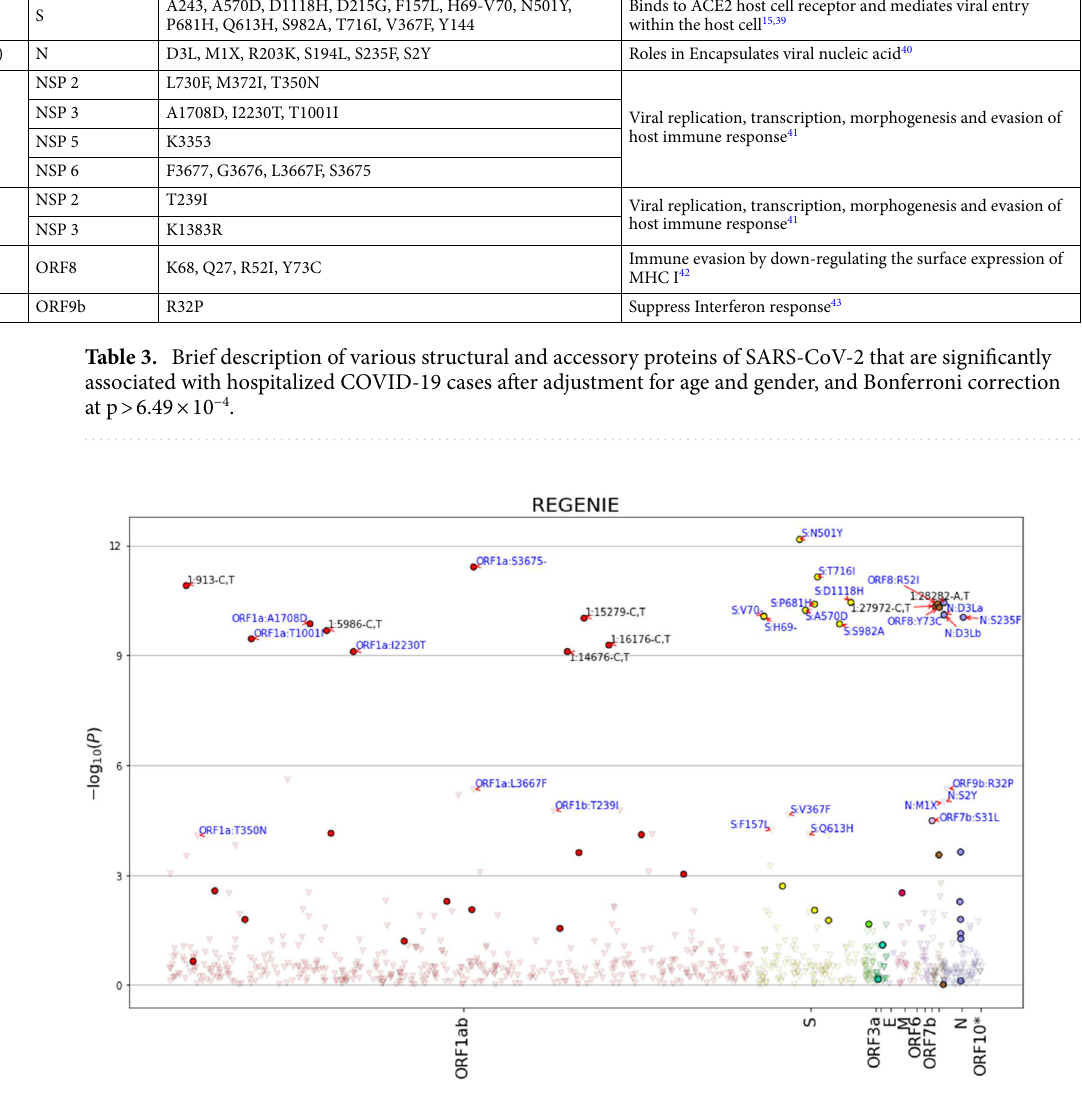
Figure 3. Manhattan plot of regenie’s GWAS on the corresponding SNPs to conduct whole genome regression on the severity